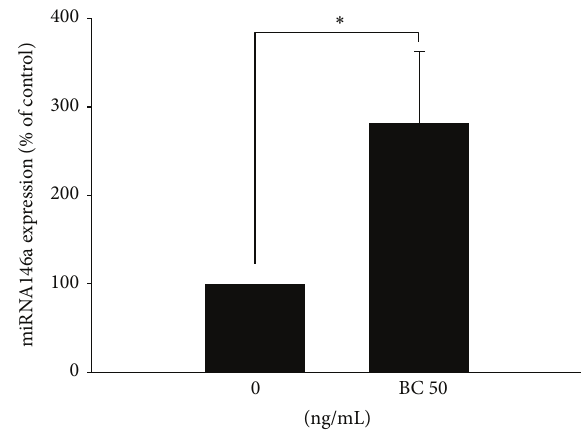
Figure 5: Upregulation of miRNA-146a expression in U937 cells after bone component (BC) exposure. U937 cells were treated with 50 ng/mL BC for 24 h. The levels of miRNA-146a in U937 cells were analyzed by quantitative real-time PCR after normalization to U6 small nuclear RNA. Data are presented as means ± SEM ( 𝑛 = 4 ); ∗ 𝑃 < 0.05 compared with the control group.